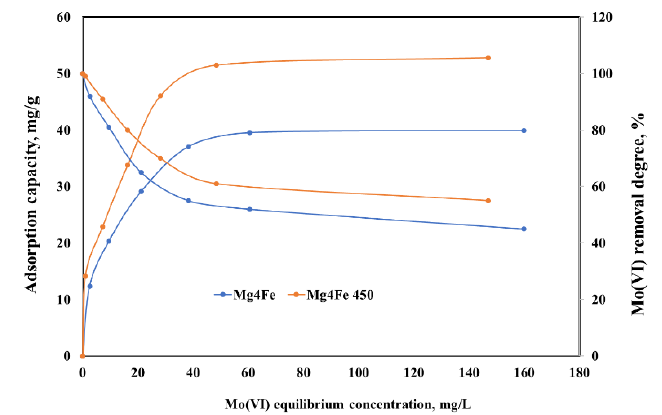
Figure 3. Equilibrium isotherms of Mo(VI) adsorption onto Mg 4 Fe and Mg 4 Fe-450. S:L = 1 g / L, t = 60 min, pH = 6, T = 20 °C.